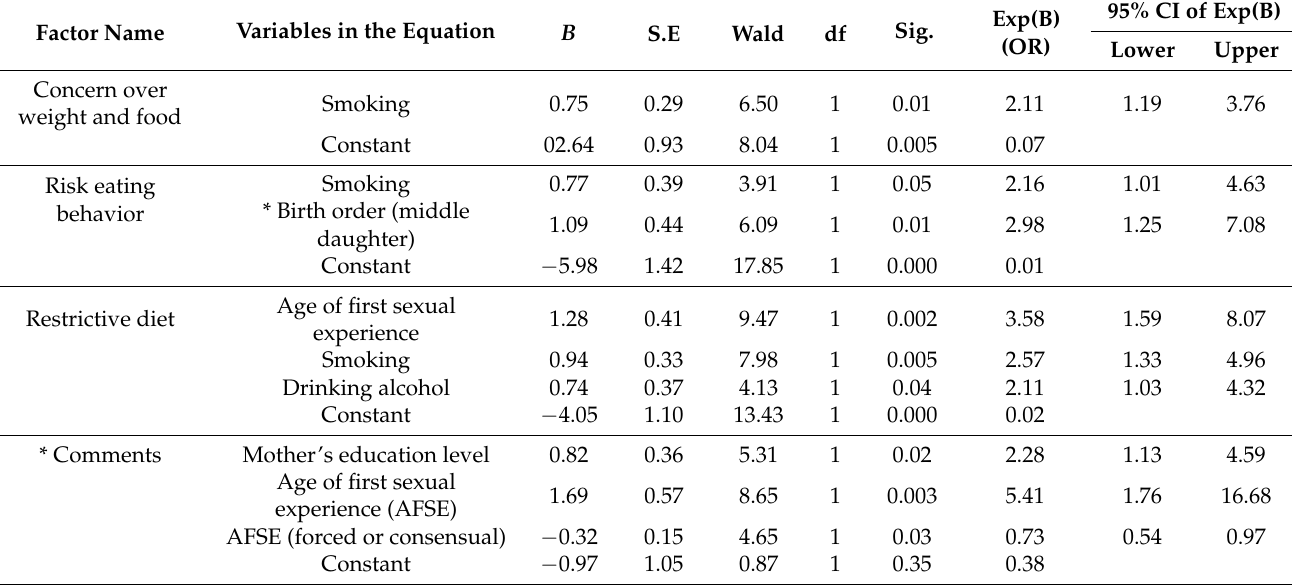
Table 3. Significant OR values (95% CI). Relationship between risk factors, comments, and sociodemographic variables. Factor